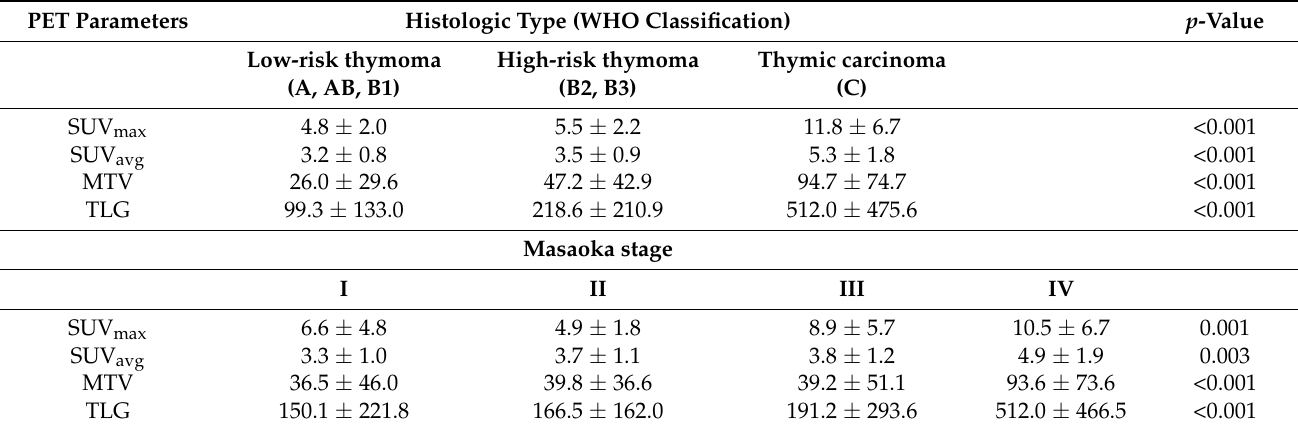
Table 2. Positron emission tomography (PET) parameters by Masaoka stage and histologic type (WHO classification). PET Parameters Histologic Type (WHO Classification) p -Value Low-risk